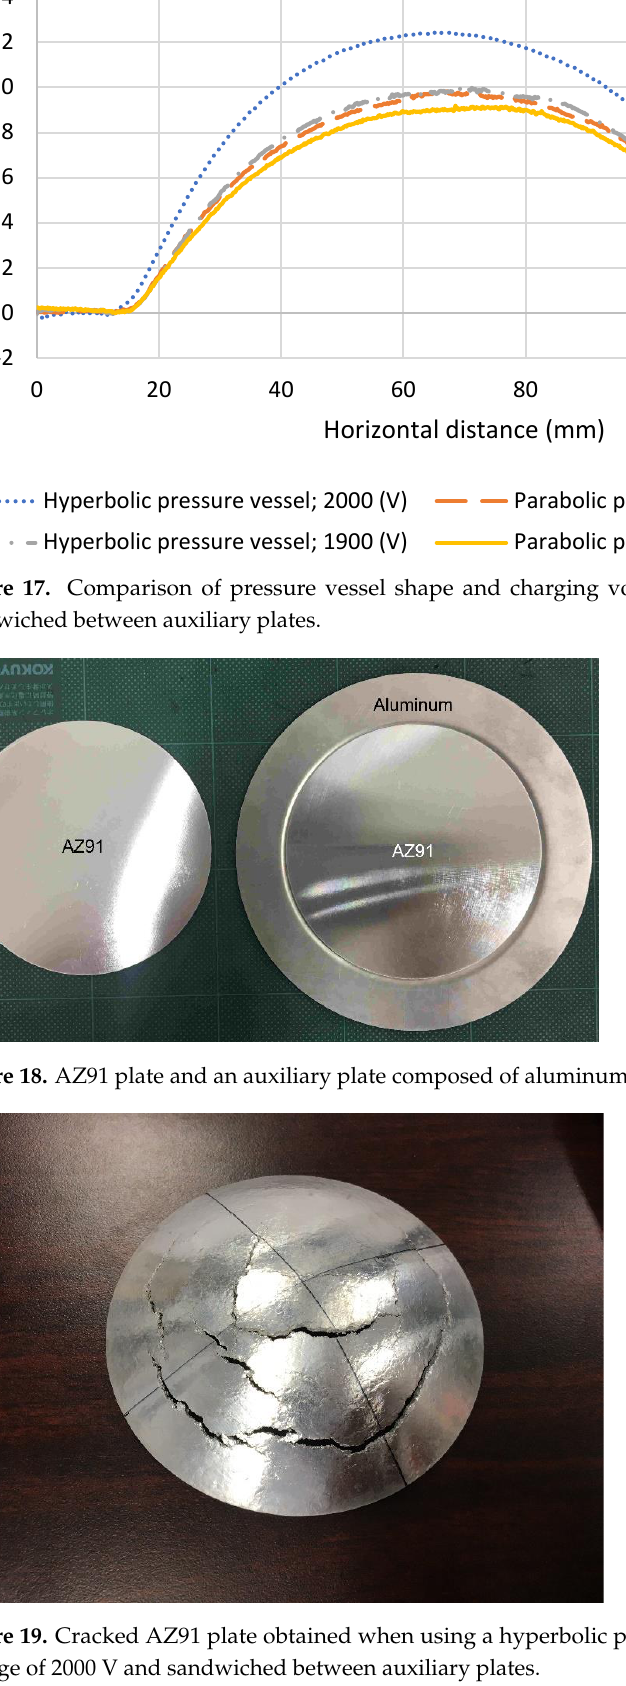
Figure 19. Cracked AZ91 plate obtained when using a hyperbolic pressure vessel with a charging voltage of 2000 V and sandwiched between auxiliary plates.